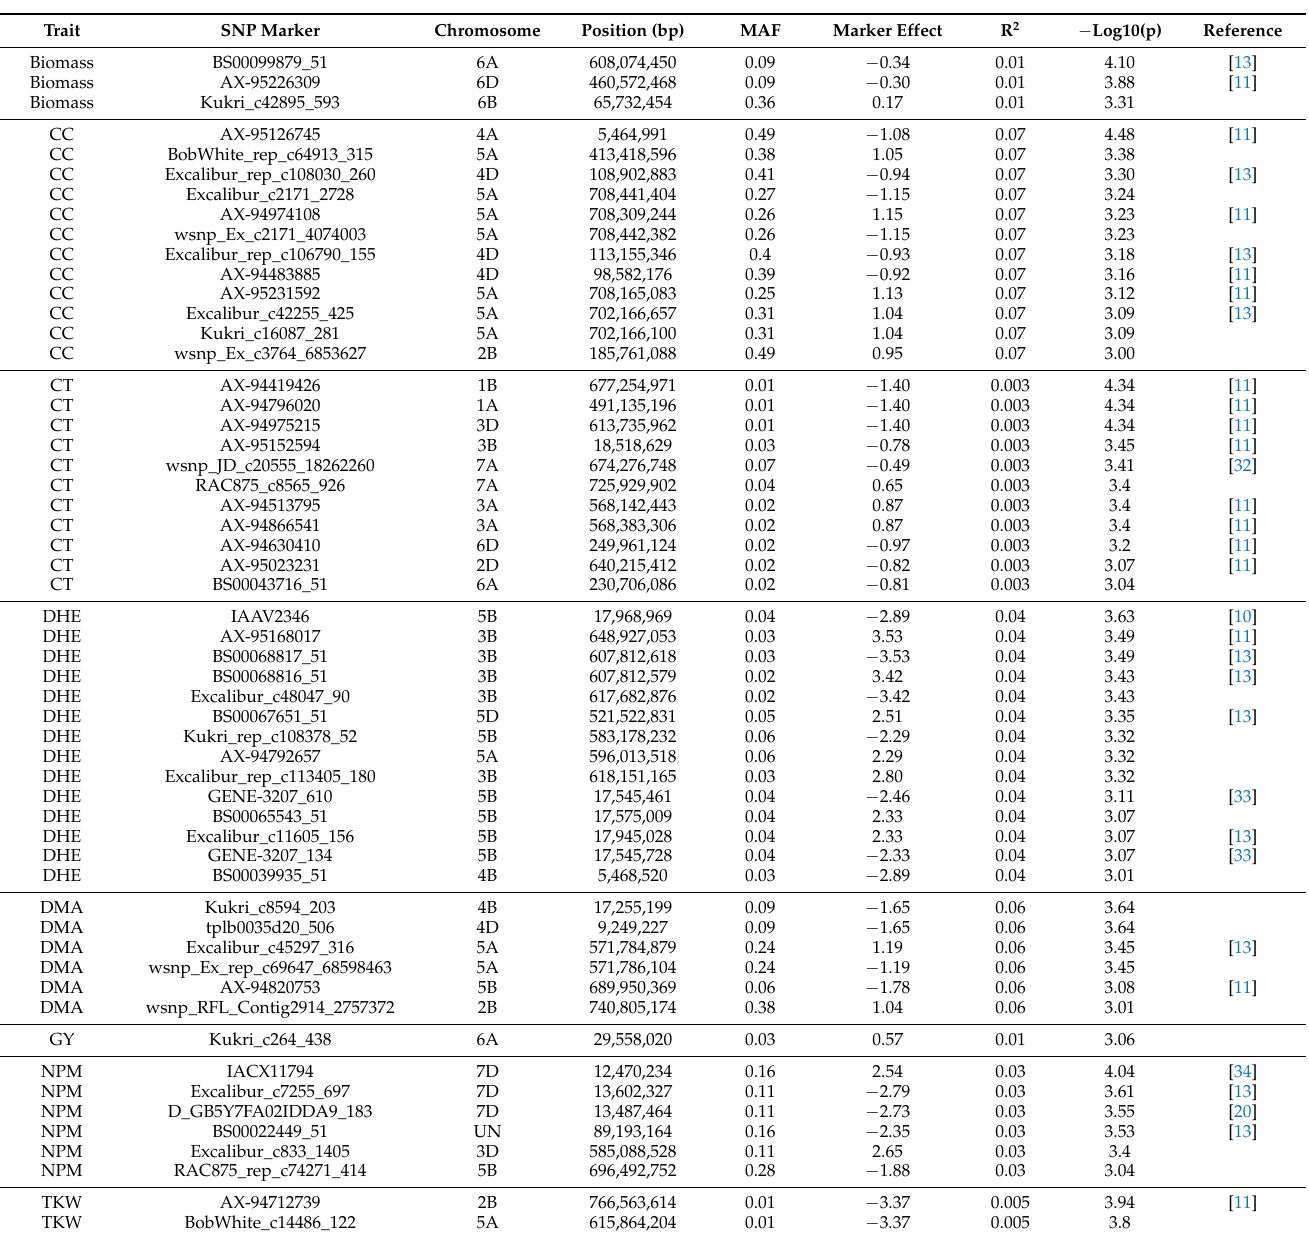
Table 4. List of the significant markers associated with Biomass, CC, CT, DHE, DMA, GY, NPM, and TKW from genome-wide association analysis of 200 bread wheat genotypes under rainfed conditions at Merchouch